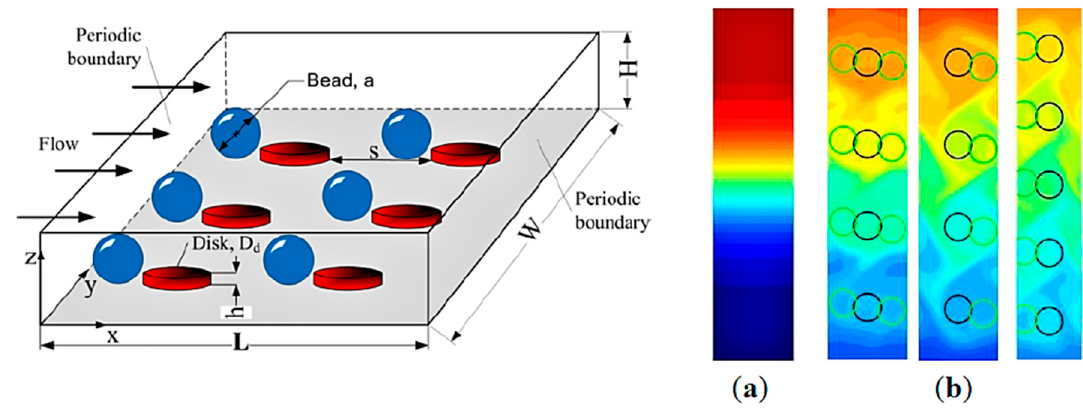
Figure 14. (left) Computational setup of the magnetic mixer. (right) Comparison of mixing efficiency between pure diffusion (a) and magnetic mixer without channel flow after 100 bead revolutions (b). The concentration is averaged over channel height. The back circles denote the position of static discs, whereas the green circles indicate the instant position of rotating beads. In (b), left, 2 beads rotation per disk with 2a spacing; middle, 1 bead per disk with 2a spacing; right, 1 bead per disk with 1.5a spacing. (Re-printed from Owen et al. [119]. Copyright (2013), with permission from MDPI AG).